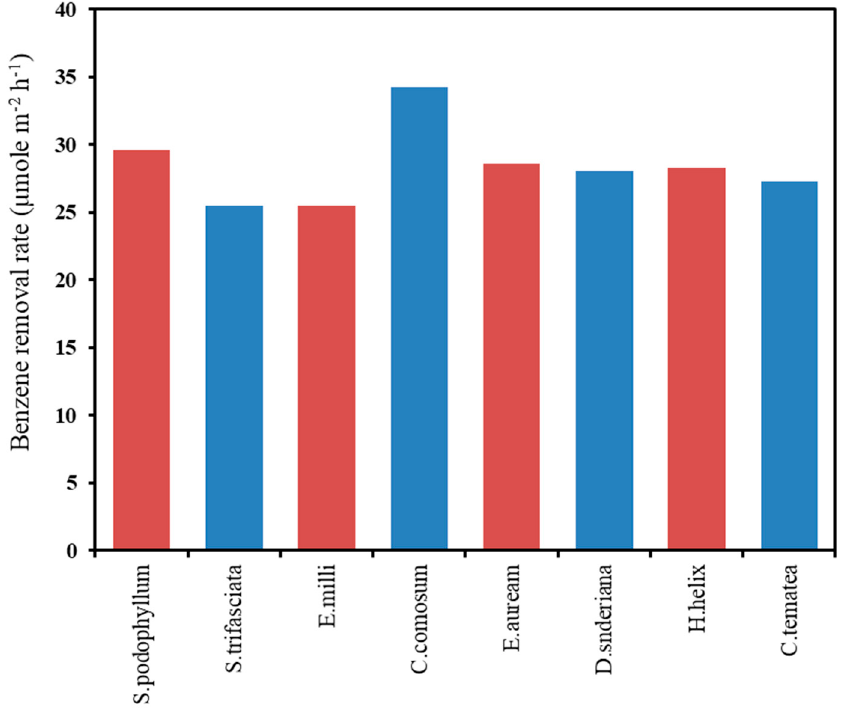
Figure 6. Comparison of benzene removal rate for eight plant species [8] .